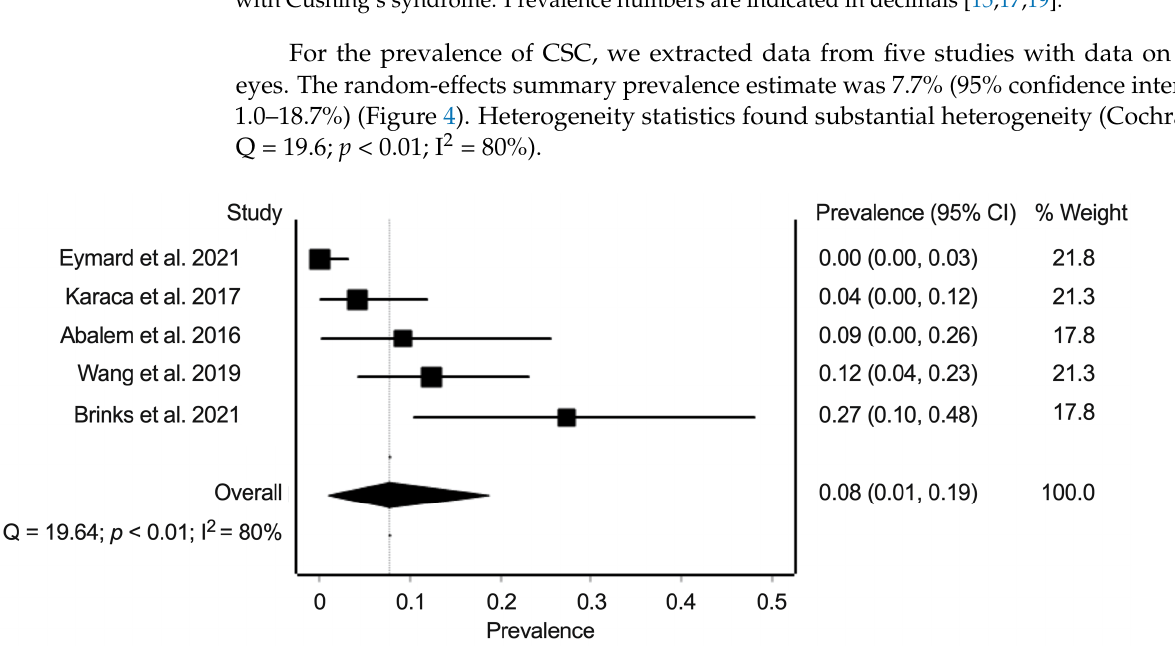
Figure 4. Meta-analysis of the prevalence of central serous chorioretinopathy in eyes of patients with Cushing’s syndrome. Prevalence numbers are indicated in decimals [15–18,20].